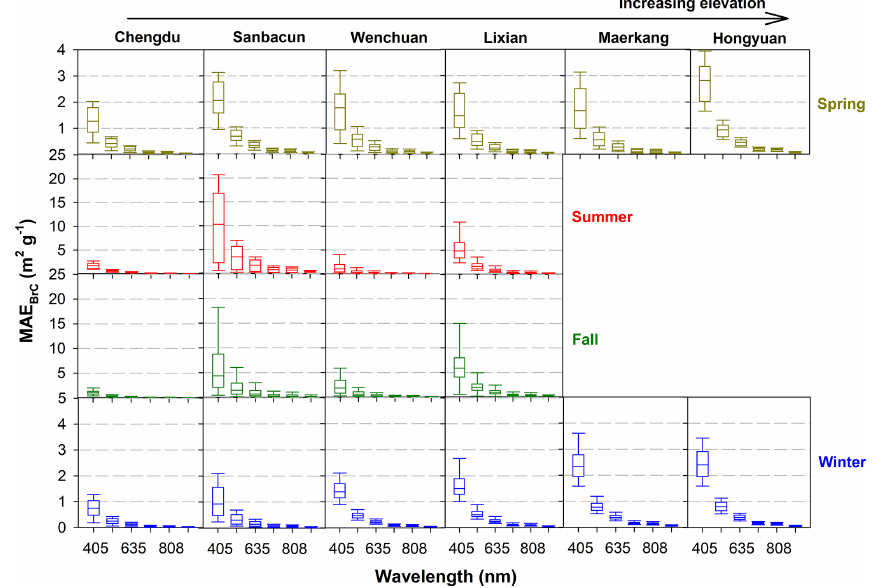
Figure 3. Box plots of spectral mass absorption efficiency of BrC (MAE BrC ) in each season from Chengdu inside the SCB to Hongyuan over the TP ranging in elevation from 500 to 3500m. The lines inside the boxes denote the median values, and the two whiskers and the top and bottom of the boxes denote the 5th and 95th and the 75th and 25th percentiles, respectively.